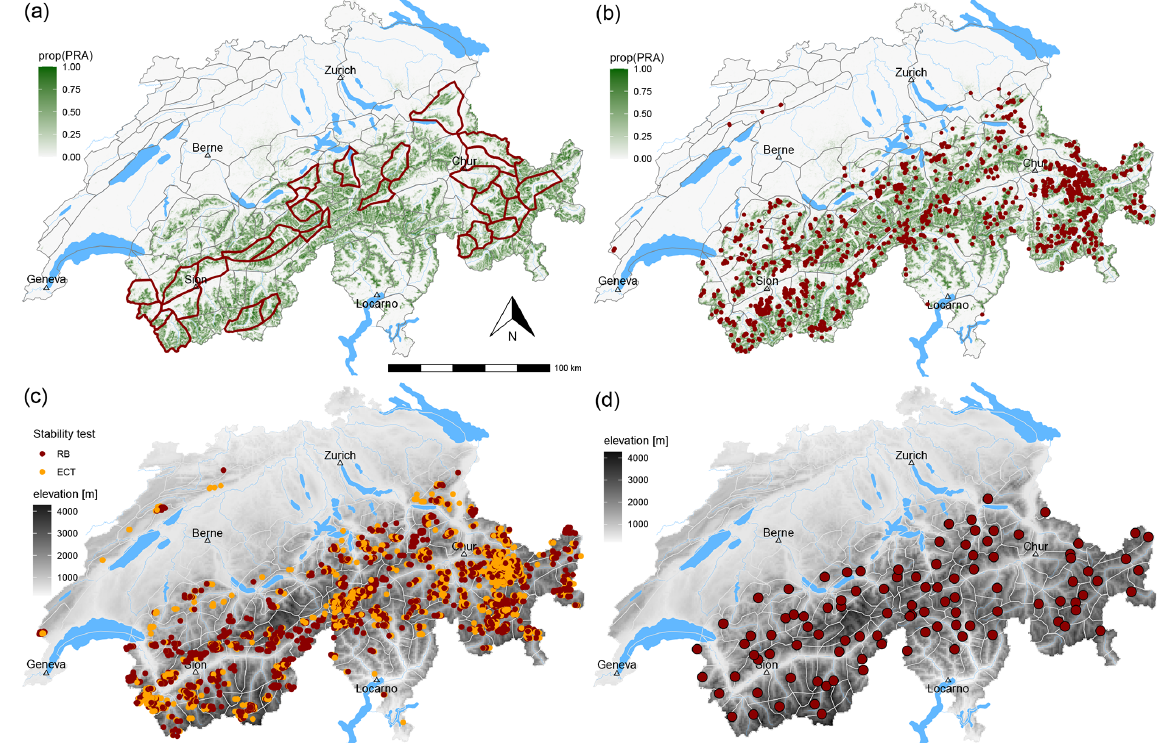
Figure A1. Maps of Switzerland showing (a) the warning regions (grey polygon boundaries) and those selected for the analysis of natural avalanches (bold polygons), (b) the location of human-triggered avalanches (dots), (c) the location of stability tests (dots), and (d) the location of the automatic weather stations where the two models were run (points). For illustration purposes, color shading in the background represents (a, b) the proportion of potential release areas (prop(PRA)) according to Bühler et al. (2018) per 500 × 500m grid cells and (c, d) elevation based on a digital elevation model (source: SwissTopo).